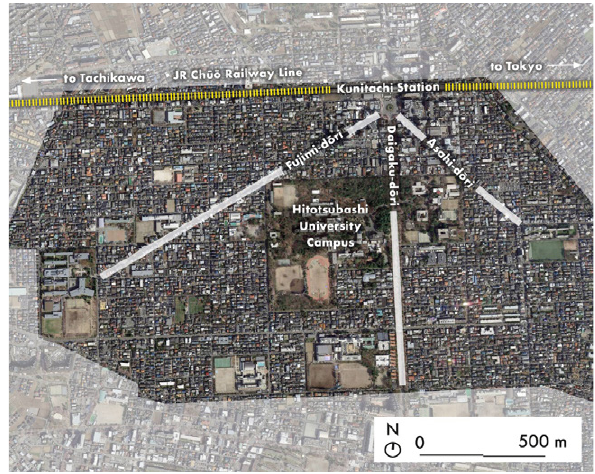
Figure 1. Aerial view of